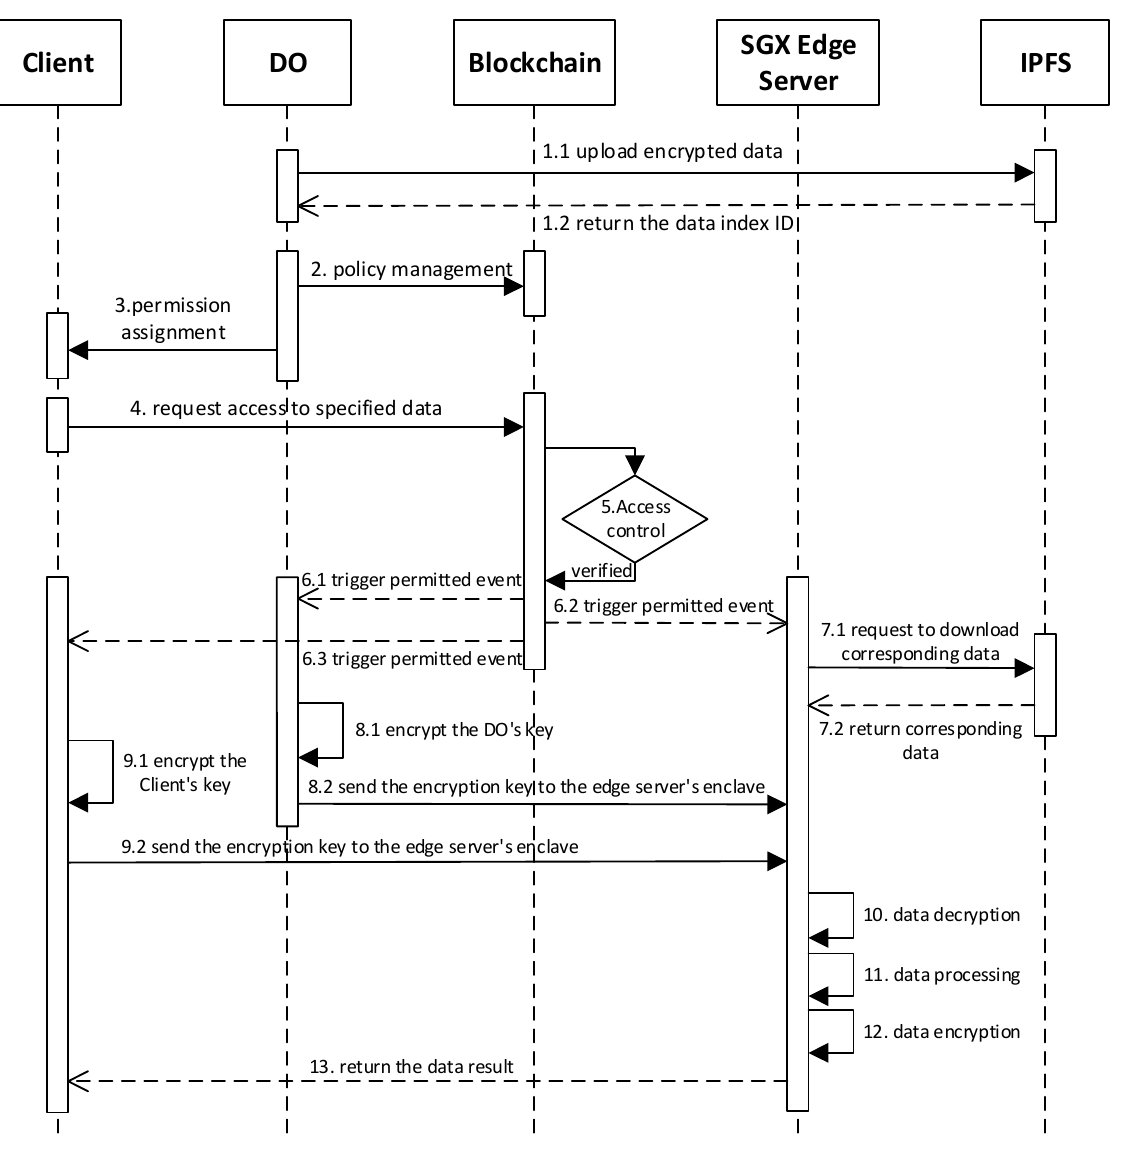
Figure 8. Figure 8. The UML sequence diagram of IoT data access and processing flow based on SGX edge computing.